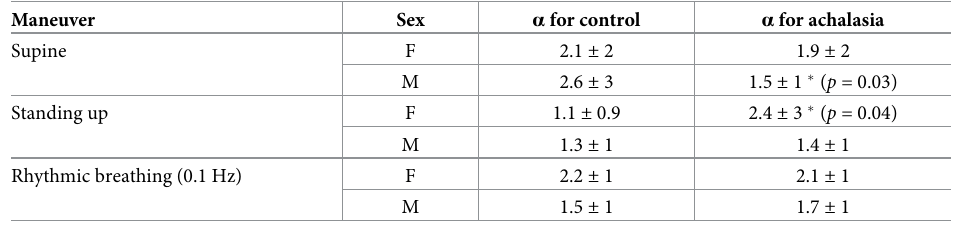
Table 4. Homeostatic measure parameter α .